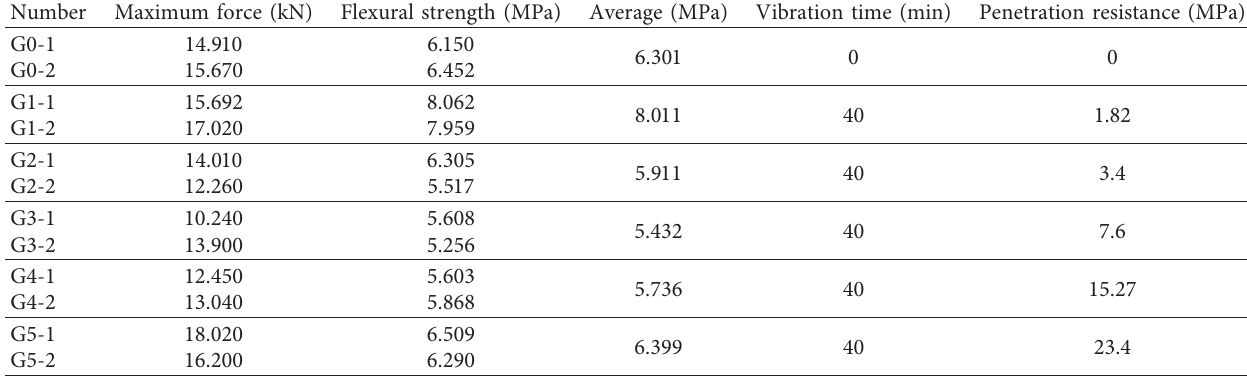
Table 4: Flexural data of basalt fiber concrete.